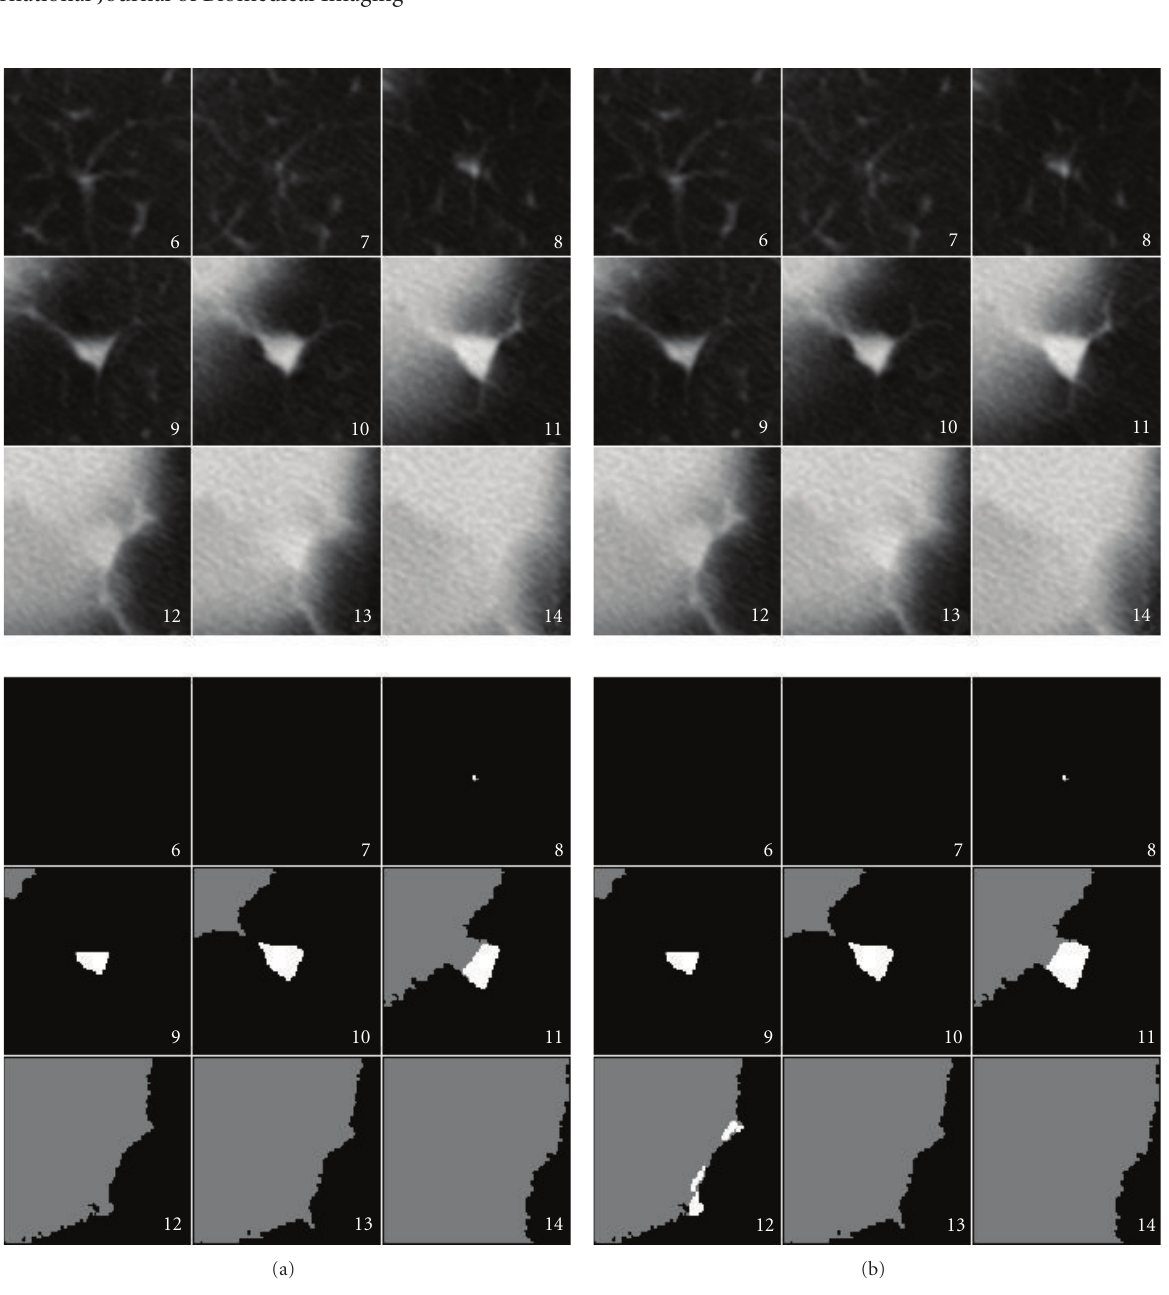
Figure 16: Several slices of the region of interest containing a nodule that the (a) surface-fitting and (b) plane-cutting methods failed to properly segment. The nodule was located near the diaphragm; notice that there was a large change in the position of the wall in frames 9 to 11. The voxels included in the segmentation are indicated in white, while high-intensity nonnodule voxels are shown in